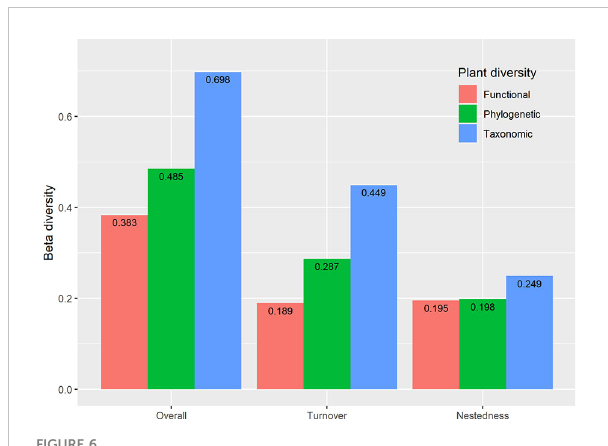
FIGURE 6 Multifaceted plant overall beta diversity, turnover, and nestedness within the reservoir riparian zone regulated by the Three Gorges Dam on the Yangtze River in China.